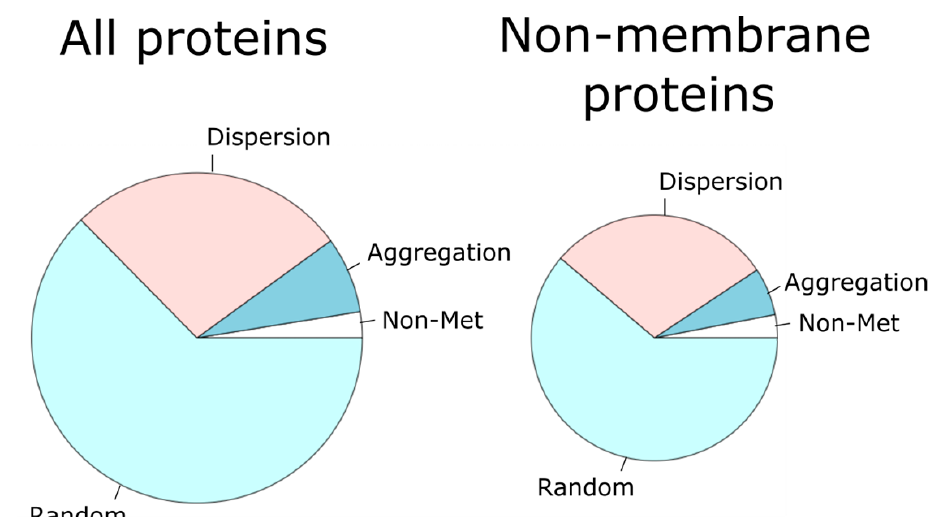
Figure 3. For each protein, the observed distribution of methionine residues along the linear sequence was contrasted with that expected when these residues were randomly distributed. In this way, each protein was sorted into the aggregation, dispersion, or random category. The pie chart on the left represents the percentage of all the proteins in each category. The pie chart on the right gives these proportions for only non-membrane proteins.